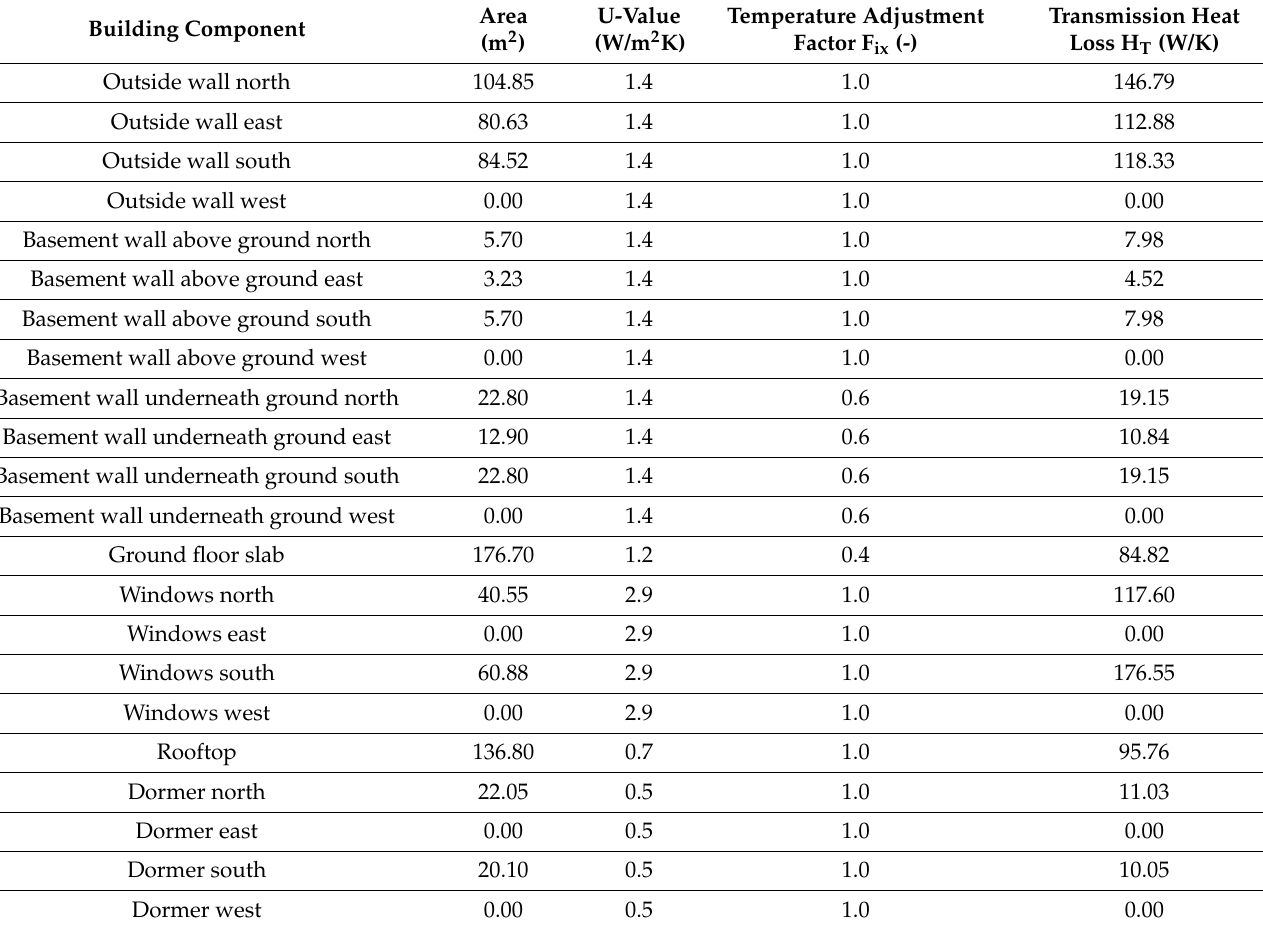
Table A33. Area sizes, U-values, temperature adjustment factors, and transmission heat losses of components of the reference building